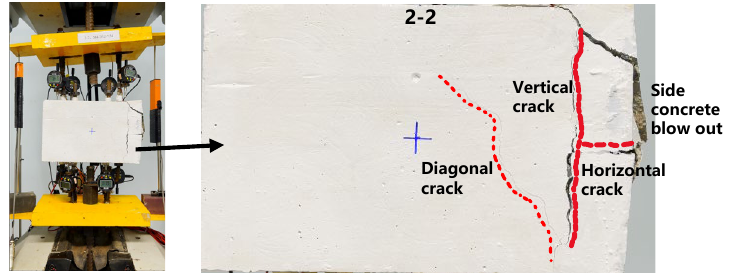
Figure 7. Crack development at post-peak stage.